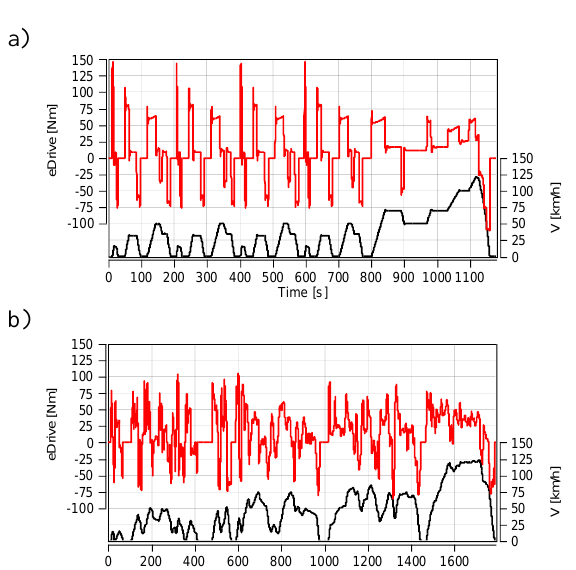
Fig. 6. The electric drive motor torque and vehicle speed characteristics obtained in the tests: a) NEDC, b) WLTC density of this engine's operating points in the WLTC test